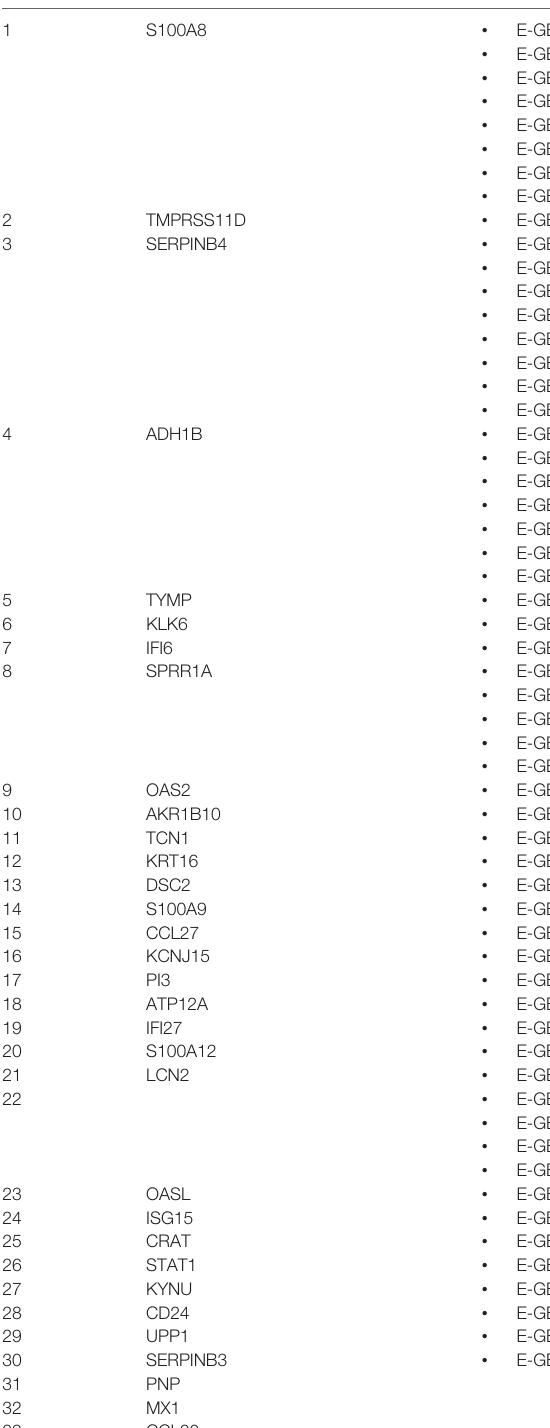
TABLE 6 | Potential biomarkers and therapeutic targets for psoriasis and cSCC. Sr.